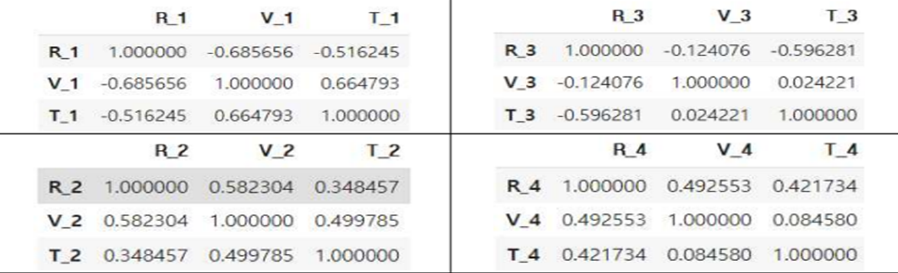
Figure 3. Correlation for each cell .